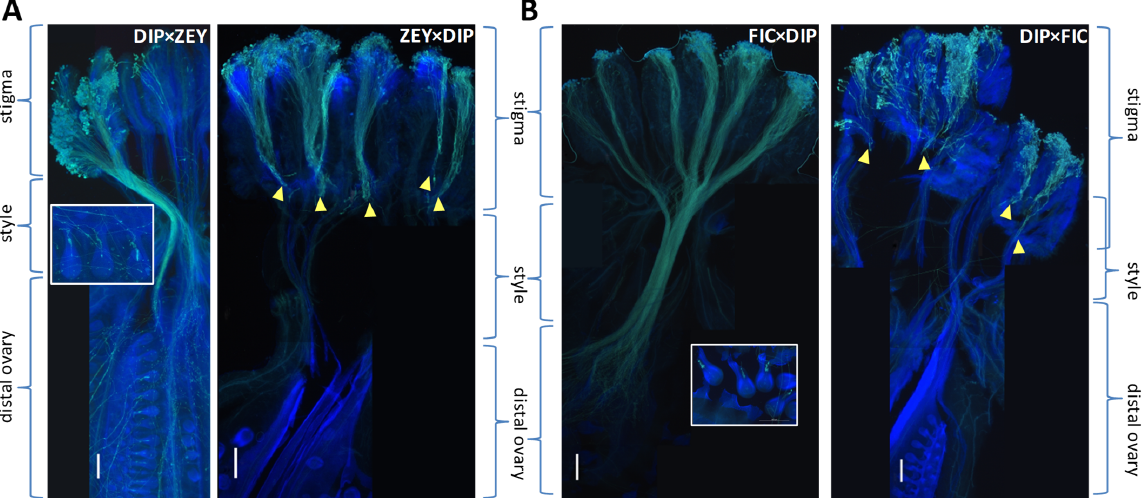
Figure 3. Unilateral cross-incongruity/incompatibility in Cucumis . ( A ) Hybridization between DIP and ZEY. Direct DIP × ZEY and reciprocal ZEY × DIP crosses are shown. ( B ) Hybridization between FIC and DIP. Direct FIC × DIP and reciprocal DIP × FIC crosses are shown. Insets show details of fertilized ovules in the DIP × ZEY, and FIC × DIP crosses. Yellow arrowheads indicate sites of pollen tube arrest. Scale bars correspond to 500 µ